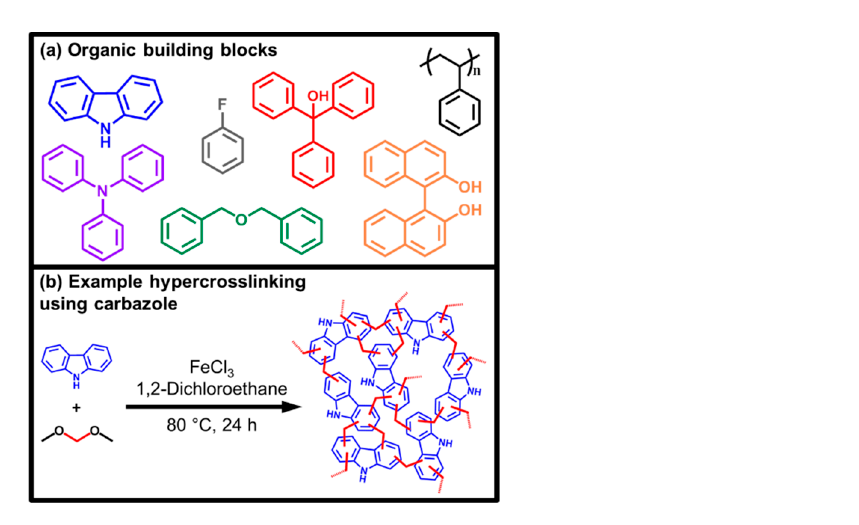
Figure 1. Schematic representation of hypercrosslinked polymer (HCP) synthesis using the so-called external crosslinking or “knitting” method. ( a ) Example monomers used in this work, poly(styrene), triphenylmethanol, BINOL, carbazole, triphenylamine, dibenzyl ether and fluorobenzene and ( b ) an example of hypercrosslinking synthesis.